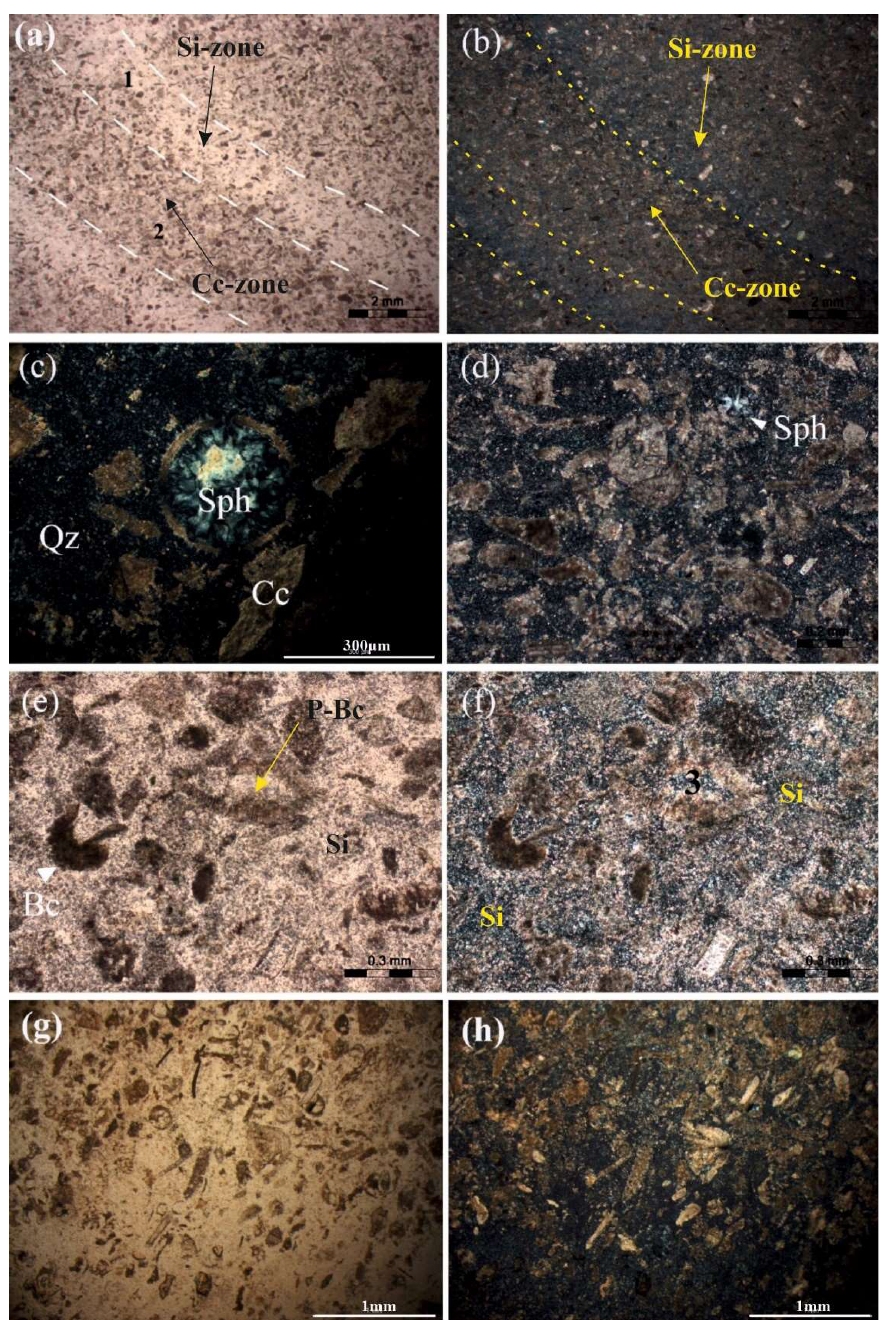
(Figure 6a,b). This mechanism led to the different ratios of silicate/carbonate minerals in different zones as is evident in the microscale observation.